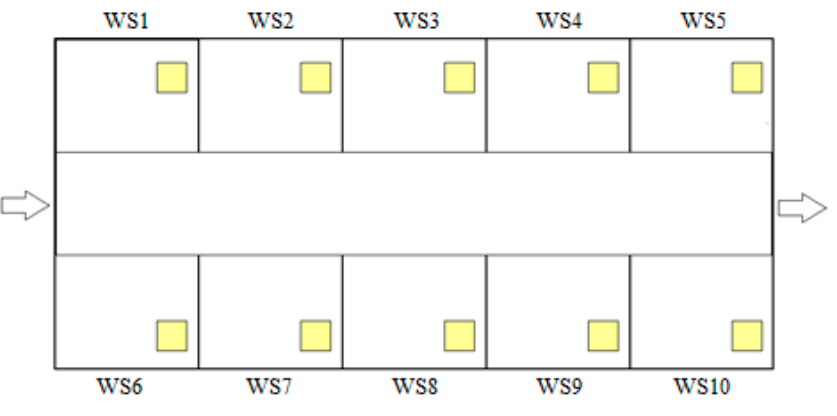
Figure 4. Representative Job-shop Layout Plan.